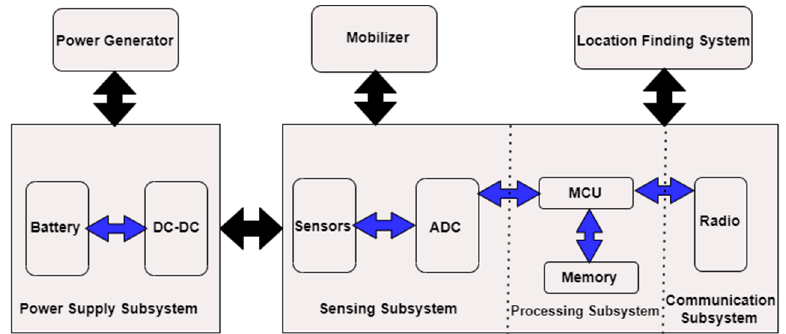
Figure 10. The architecture of a wireless sensor network [49].